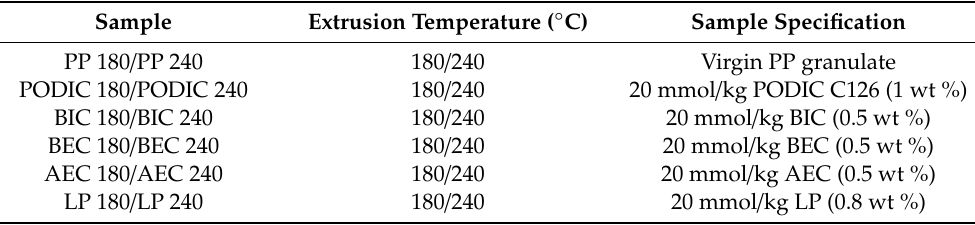
Table 2. Sample compositions and processing